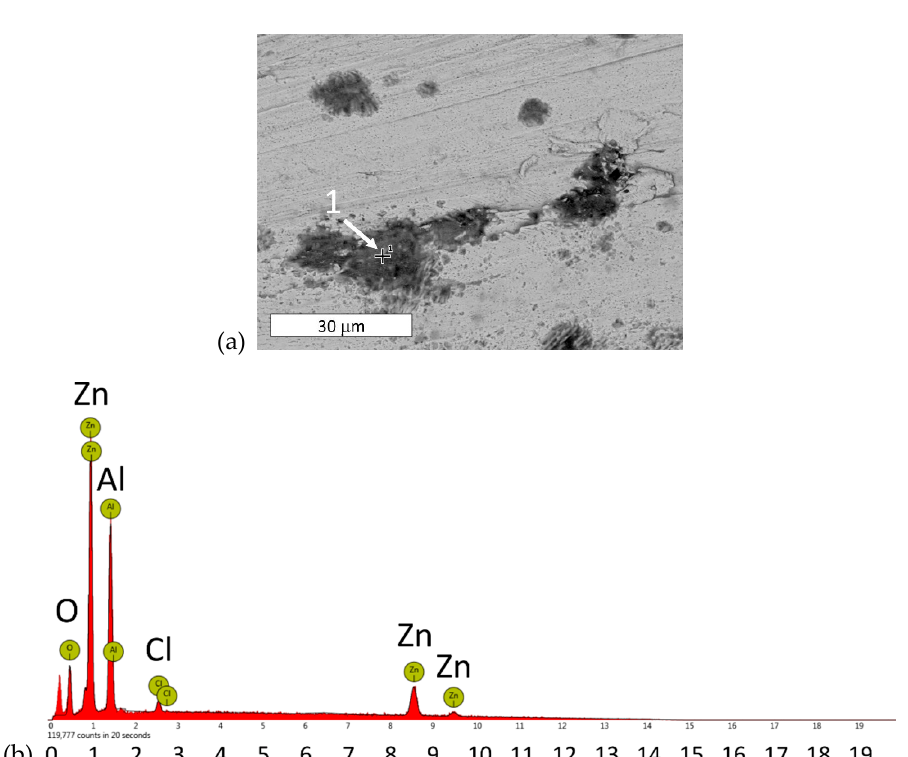
Figure 7. ( a ) SEM image of the surface of a sample after polarization up to a potential of +150 mV vs. E corr . Corrosion initiation areas are visible. The corrosion products are rich in aluminum and chlorine (marked with point 1 and summarized in Table 3; ( b ) characteristic X-ray emission spectrum obtained from point 1 in Figure 7a. Table 3. Chemical composition obtained from EDX analysis of point 1 in Figure 7a.